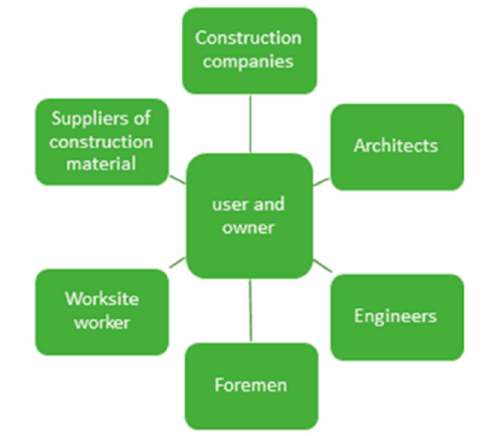
Figure 1. Representation of the main stakeholder groups identified by B2S